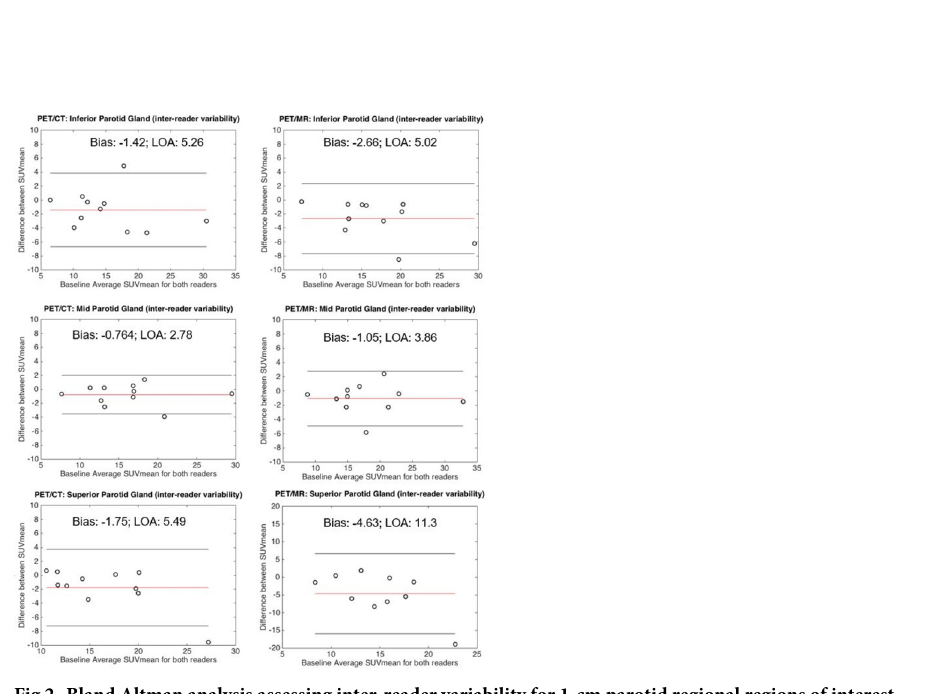
Fig 1. Bland Altman analysis assessing inter-reader variability in blood pool, liver, and whole parotid gland. Minimal inter-reader SUV mean variability is seen for blood pool (top), liver (middle), and whole parotid gland (bottom) for both wbPET/CT (left column) and wbPET/MR (right column). The calculated bias (red line) as well as the upper and lower limits of agreement (outer black lines) are demarcated on each plot. The bias and limits of agreement are listed in the top-center or bottom-center of each plot.